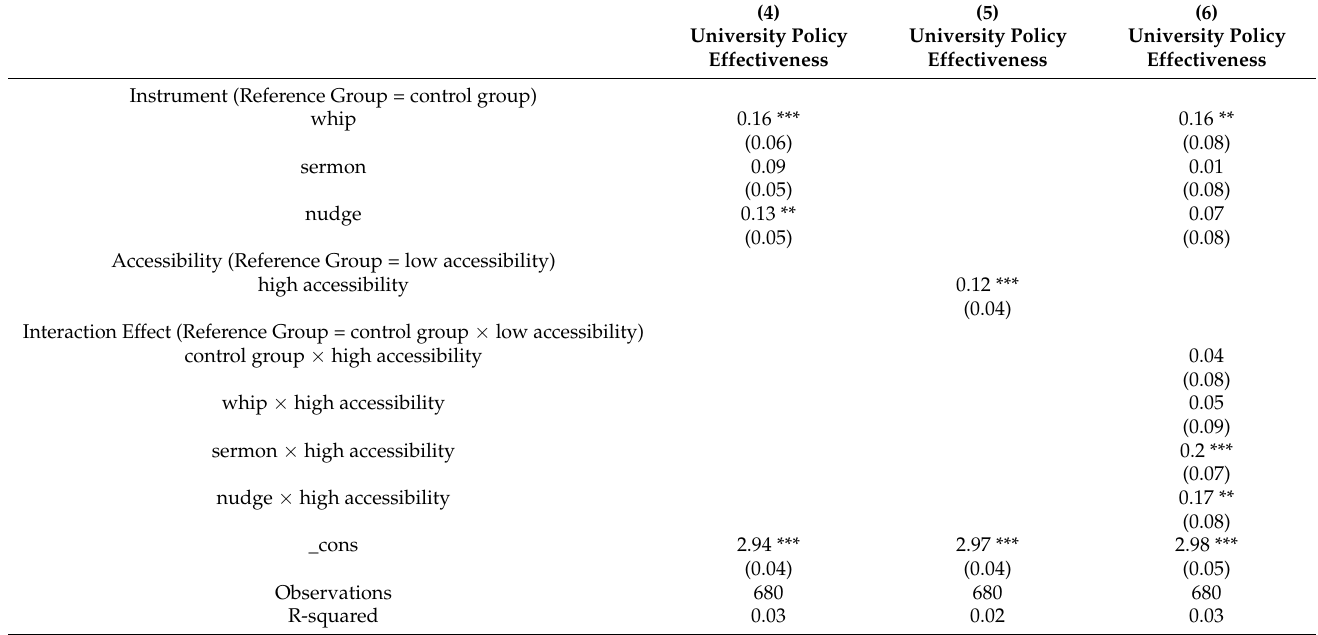
Table 4. Regression results of the effectiveness of the policy implementation.